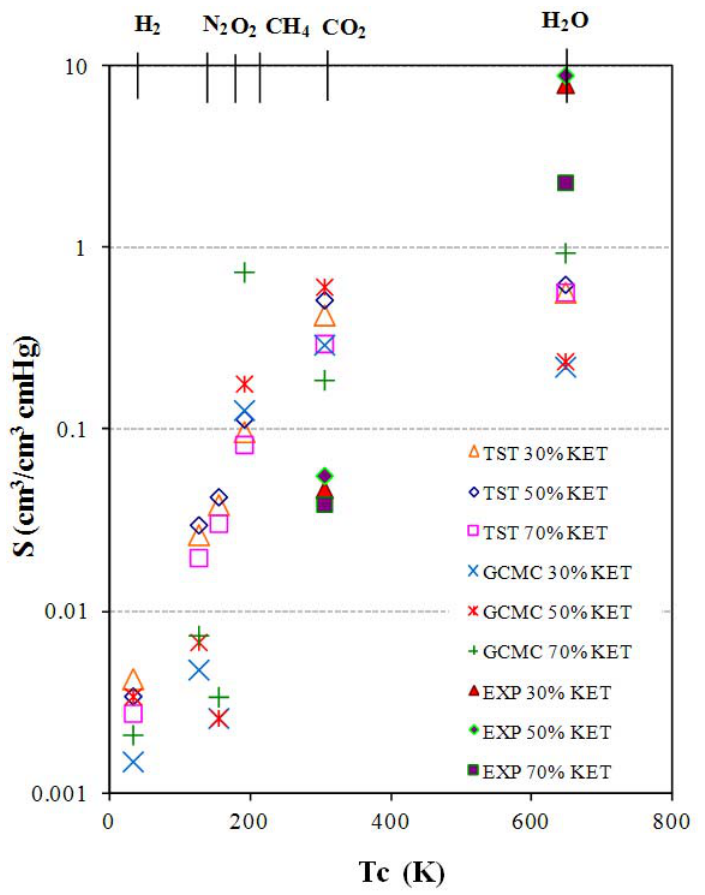
Figure 5. TST and GCMC solubility coefficients vs. Critical Temperature ( Tc ) of H O ; CH , CO , H O. Experimental data are available and reported only for CO 2 4 2 2 H O 2